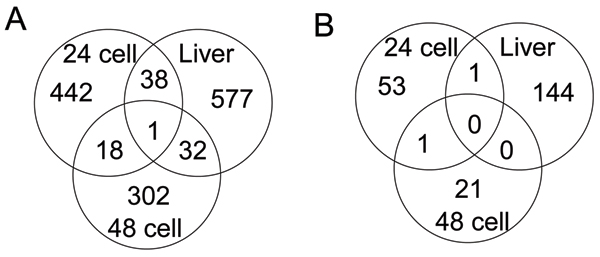
Common differentially expressed genes among all doses of exposed primary hepatic cells and liver tissue determined by ANOVA. Numbers in overlapping circles represent genes common to respective cells or tissue. 24 cell = 24 hr exposed cells, 48 cell = 48 hr exposed cells, and Liver = liver tissue. A. ANOVA analysis (p < 0.01). B. ANOVA analysis (p < 0.001).